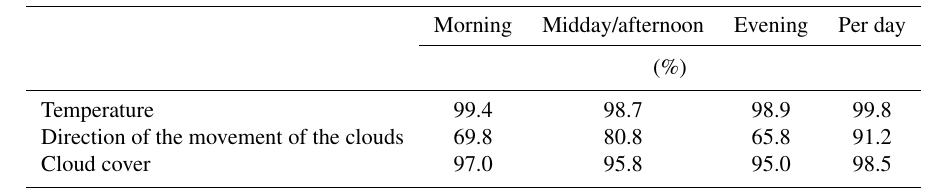
Table 1. Quality in terms of missing data and distinction between the three measurements in the morning, at midday/afternoon, and in the evening. The last column shows the percentage of days on which at least one measurement was taken.